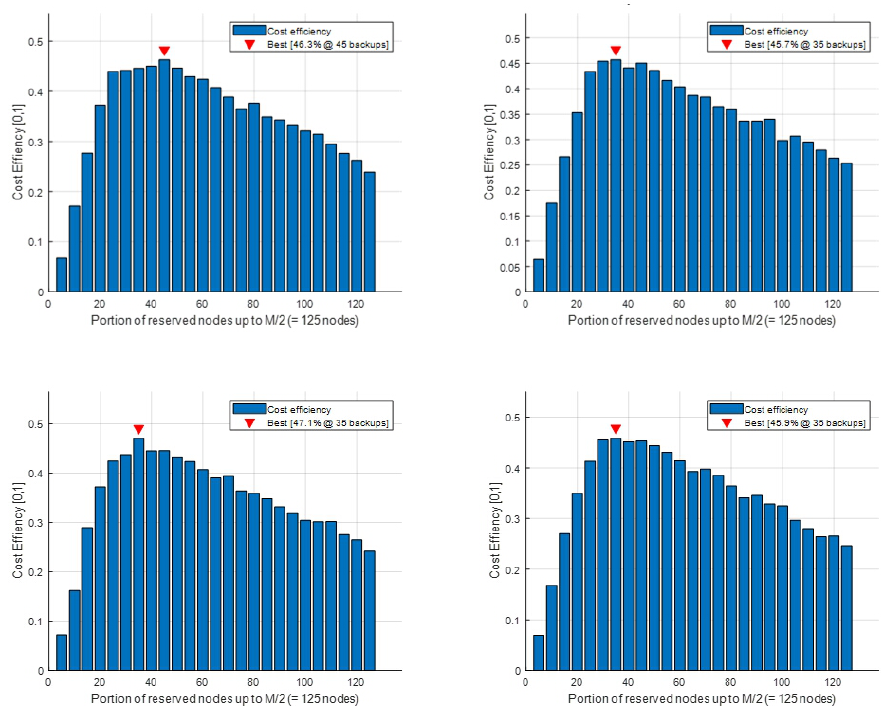
Figure 5. Simulation results to find the optimal value of the backup node.